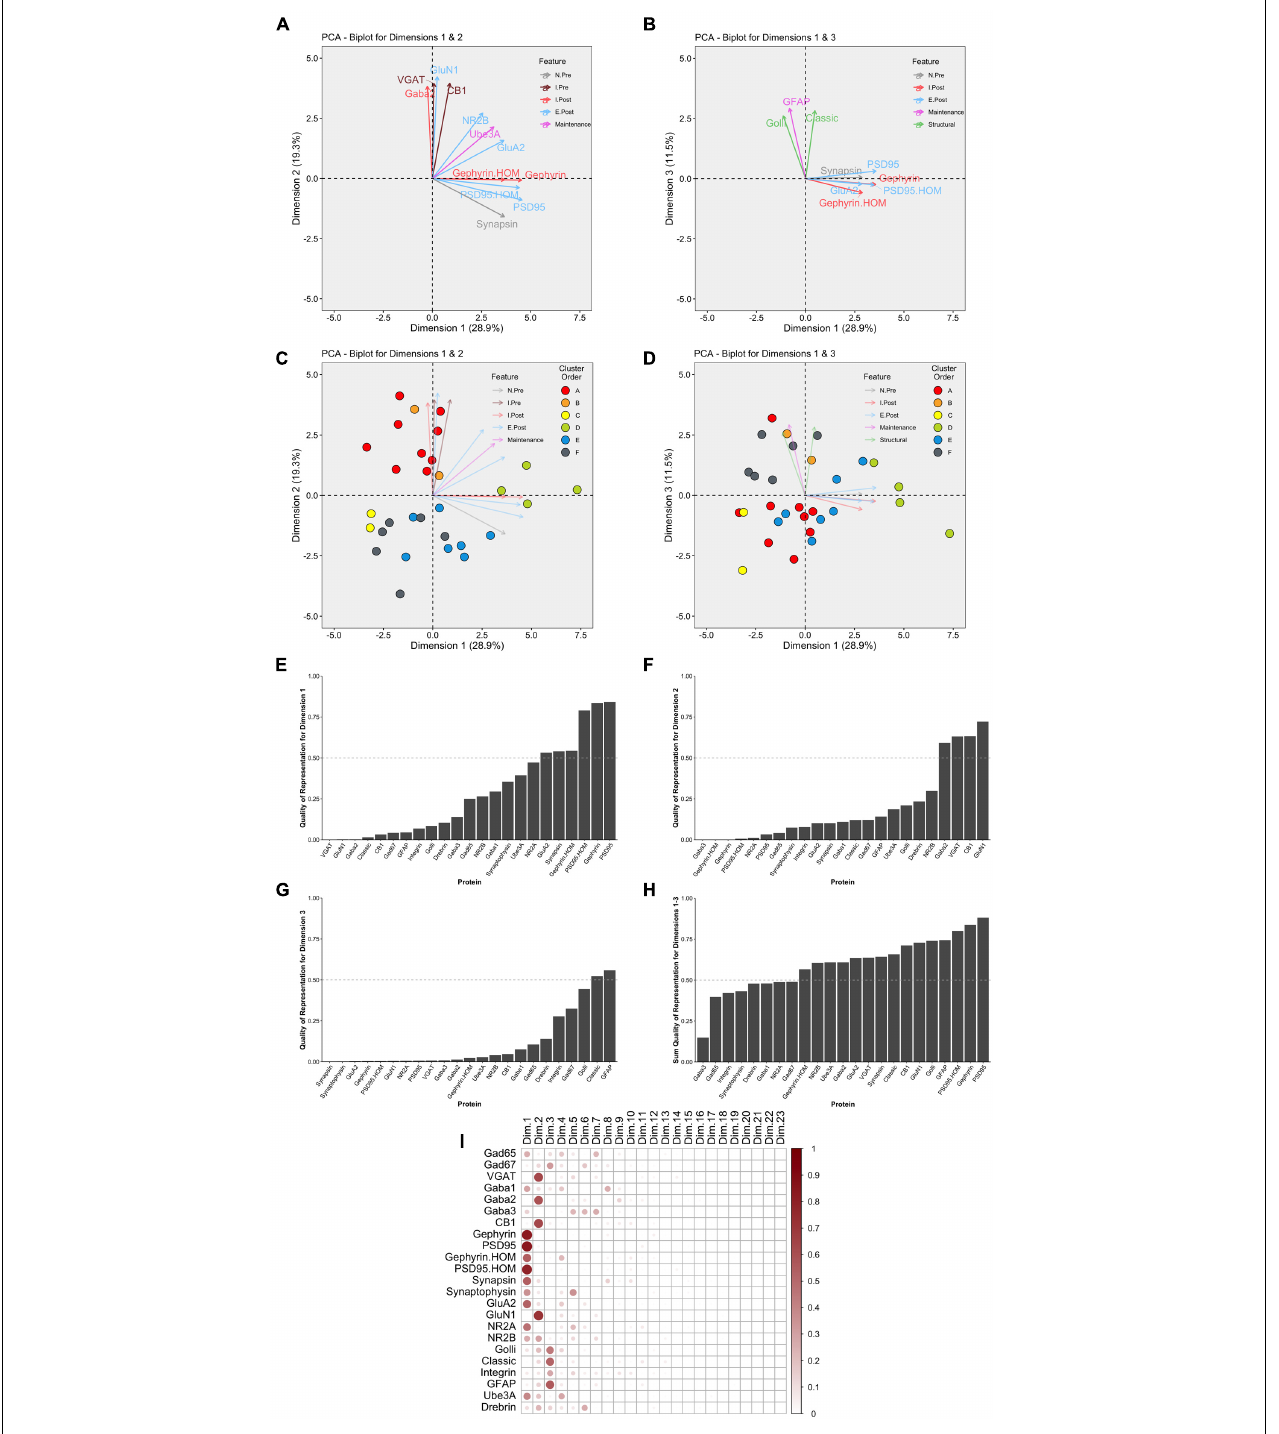
FIGURE 10 | Examination of relevant PCA identified dimensions. PCA biplots (A–D) show protein features as vectors (arrows) and individual samples as dots on pairings of PCA dimensions 1 and 2 (A,C) and dimensions 1 and 3 (B,D) . The strength of the representation (cos 2 ) for a protein on the given set of dimensions is reflected by the length of the vector, and only proteins with cos 2 > 0.5 are shown. The color of each point corresponds to their cluster, matching the original cluster colors in Figure 6 . Bar plots represent the quality of representation of each protein with each dimension (E–G) , as well as the summed quality of representation across all three dimensions (H) . The dashed line represents cos 2 cutoff value for representation of 0.5. (I) Matrix illustrating the quality of representation for each protein with each PCA dimension, representing the strength (circle size) and direction (zero = white, positive = red) of cos 2